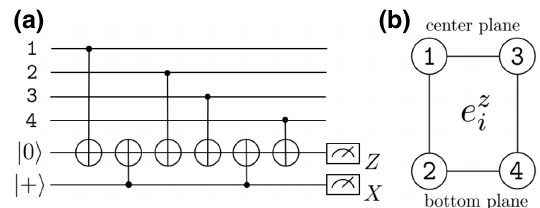
FIG. 16. (a) A flag circuit for measuring a vertical face gener- . (b) The ordering of data CNOT gates in the circuit for each ator e z i e z i